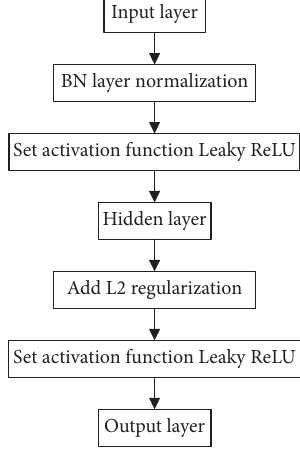
Figure 6: AE training flowchart.